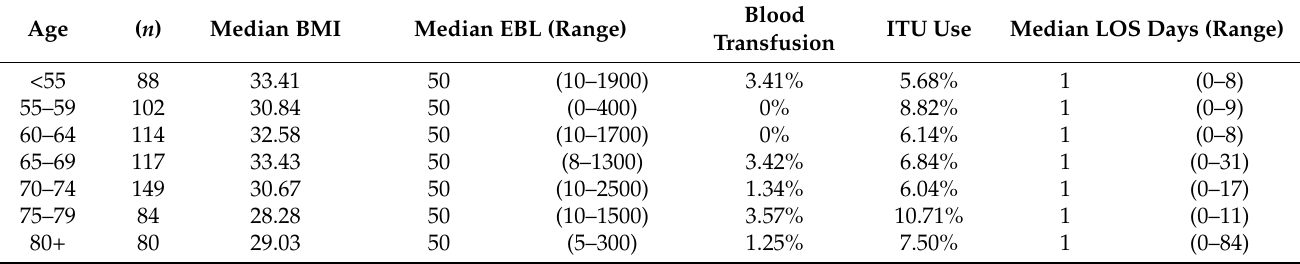
1 day as does median blood loss of 50 mL across all age groups (Table 3). Table 3. Robotic Cohort—Association between Age and Median EBL/Length of stay (LOS).